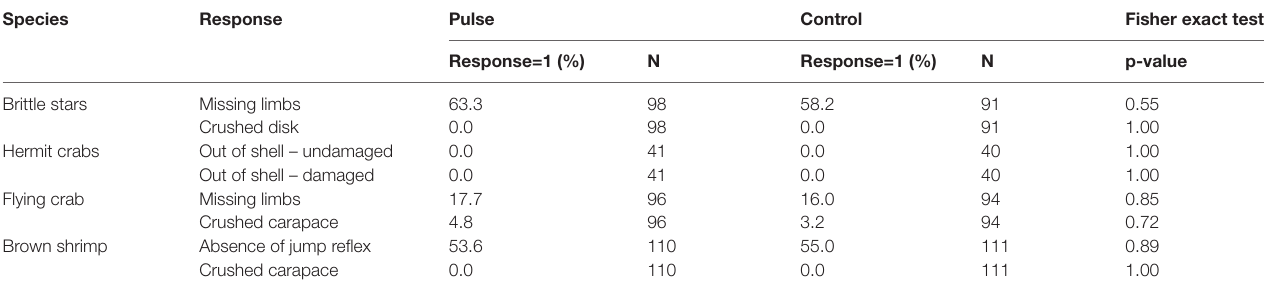
TABLE 7 | Presence of damages (response = 1, % of total number of observations, N) in brown shrimp, flying crab, hermit crab and brittle star sampled from pulse trawl tracks (Pulse) and unfished control areas (Control).